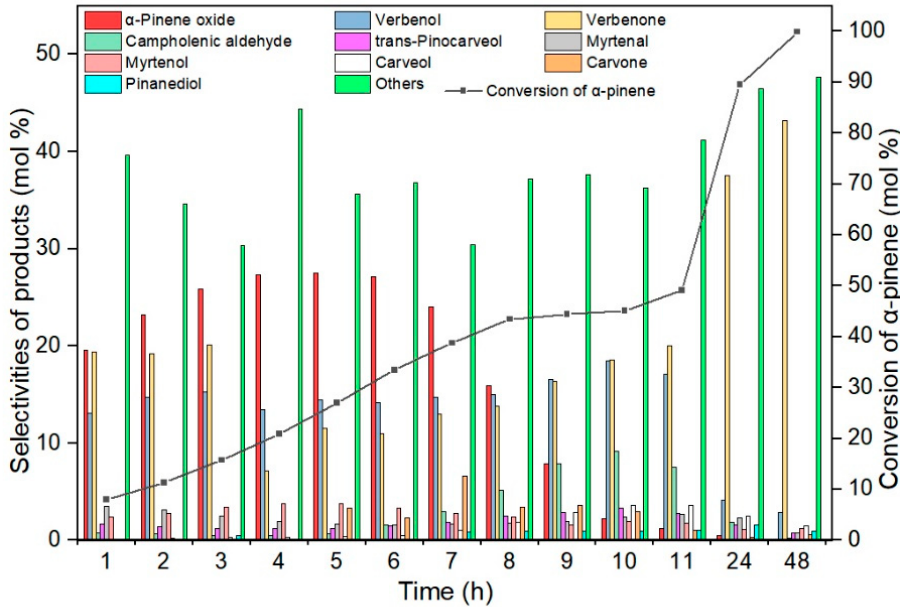
Figure 9. The influence of reaction time on the conversion of α -pinene and selectivities of appropriate products in the oxidation of α -pinene over the TS-1_2 catalyst (temperature 85 °C, catalyst content 2.5 wt%), the figure shows the sum of the selectivities of the remaining by-products, which were formed with low selectivities.